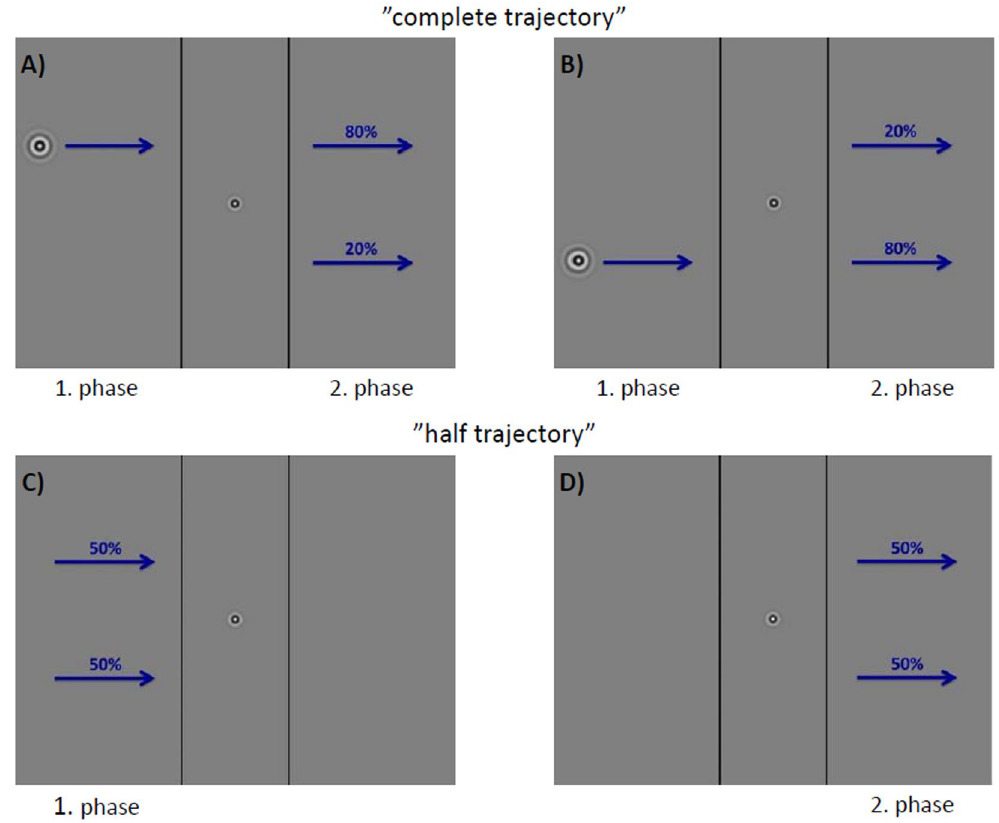
Figure 8. Examples of the possible target trajectories for the motion condition “right”. Between the two black lines the target was occluded and invisible to the participants. ( A , B ) show the condition “complete trajectory” that occurred in 5 out of 7 trials. Arrows marked with 80% indicate the standard and those marked with 20% the deviant stimuli. Condition “above” is shown in ( A ) while condition “below” is presented in ( B ). In ( C , D ) the condition “half trajectory” is presented. In ( C ) the condition “disappear” and in ( D ) the condition “appear” are schematically shown. In both cases an equal amount of trials was presented at the upper and at the lower trajectory (50%). Condition “disappear” and “appear” were each presented with a ratio of 1 out of 7. In order to control the focus of attention, the participants performed a change detection task requiring them to report changes in spatial frequency of either the central fixation target (“center”) or the peripheral motion target (“peripheral”; c.f.